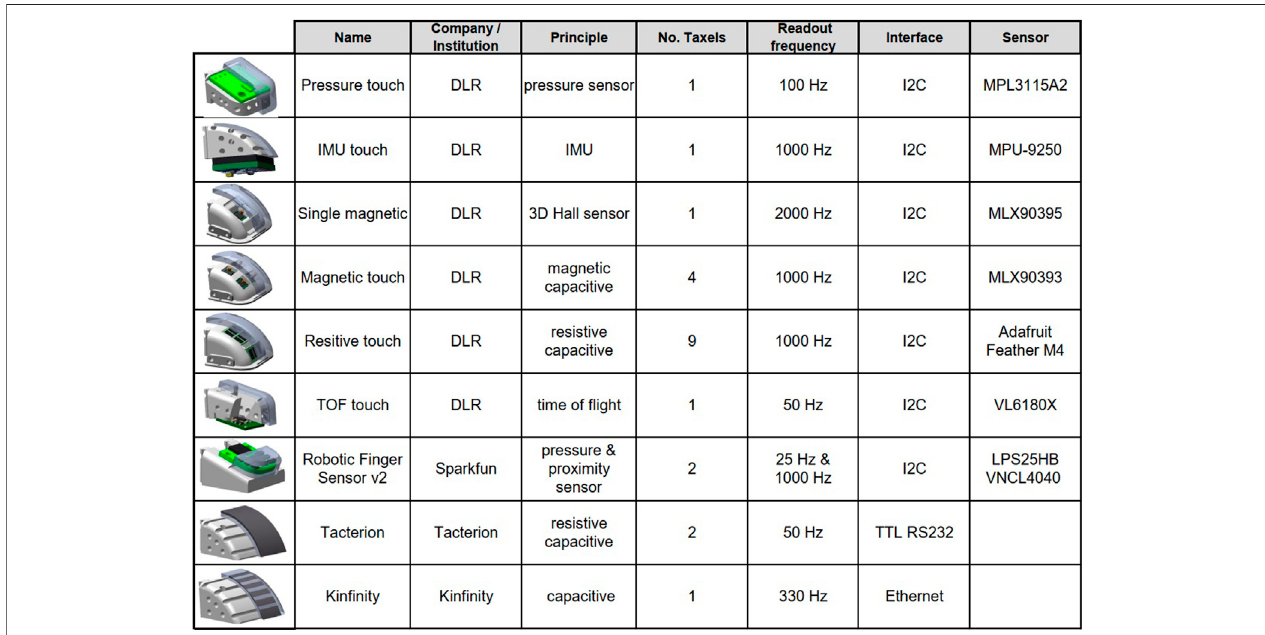
FIGURE 1 | Tactile sensors used in the comparative study, including self-made and commercially available sensors.